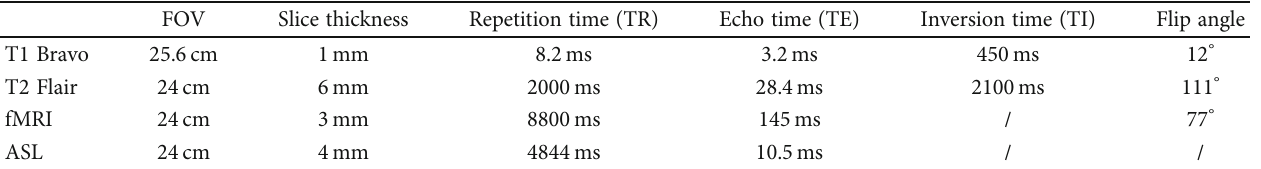
Table 3: Acquisition protocols of